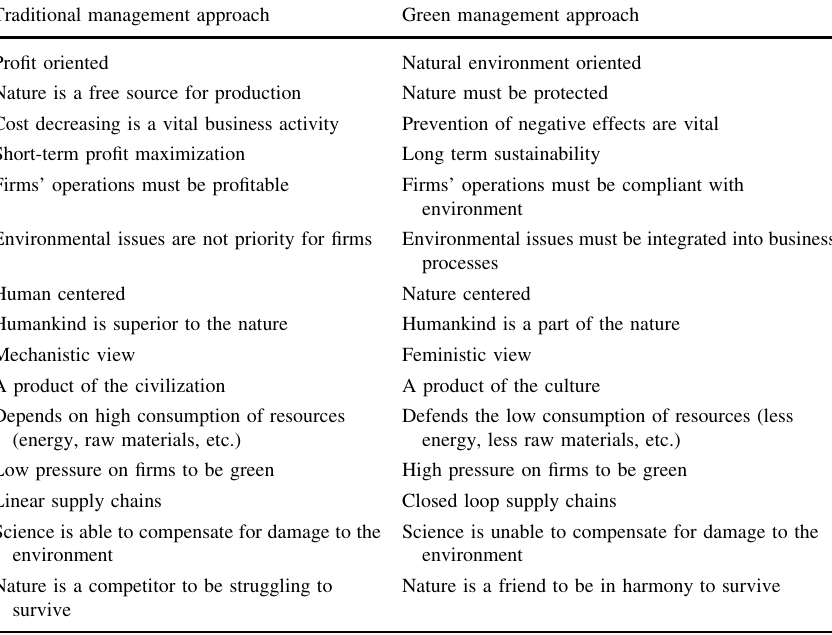
Table 1 Traditional versus green management approach Traditional management